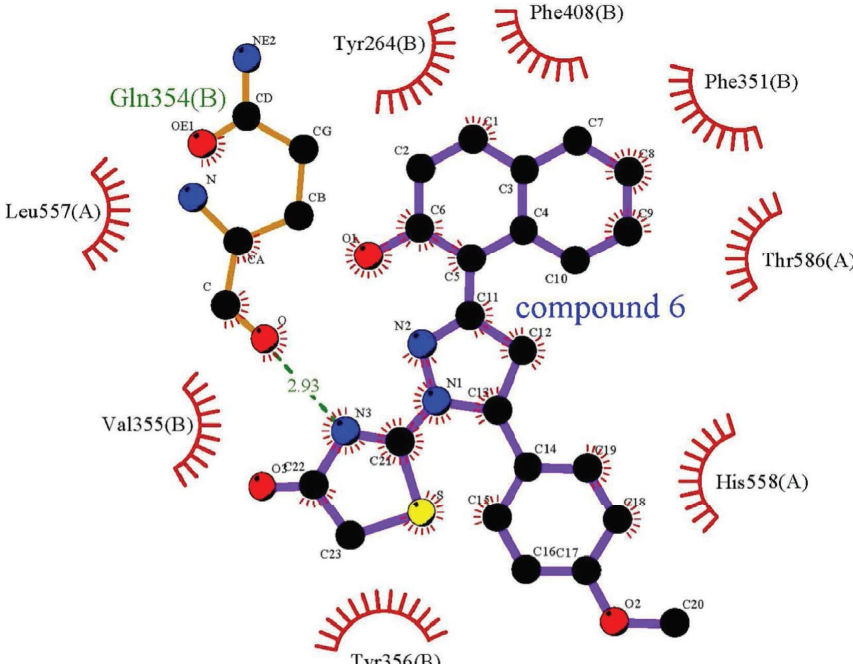
Figure 7: LigPlot analysis of the compound 6 -TLR7 complex. Te oxygen of the carbonyl group of Gln354(B) is close to the thiazolone nitrogen of compound 6 (2.93 ˚A). Eight residues, including Tyr264 (B), Phe351(B), Val355(B), Tyr356(B), Phe408(B), Leu557(A), His558(A), and Tr586(A), participate in hydrophobic interactions with compound 6 .